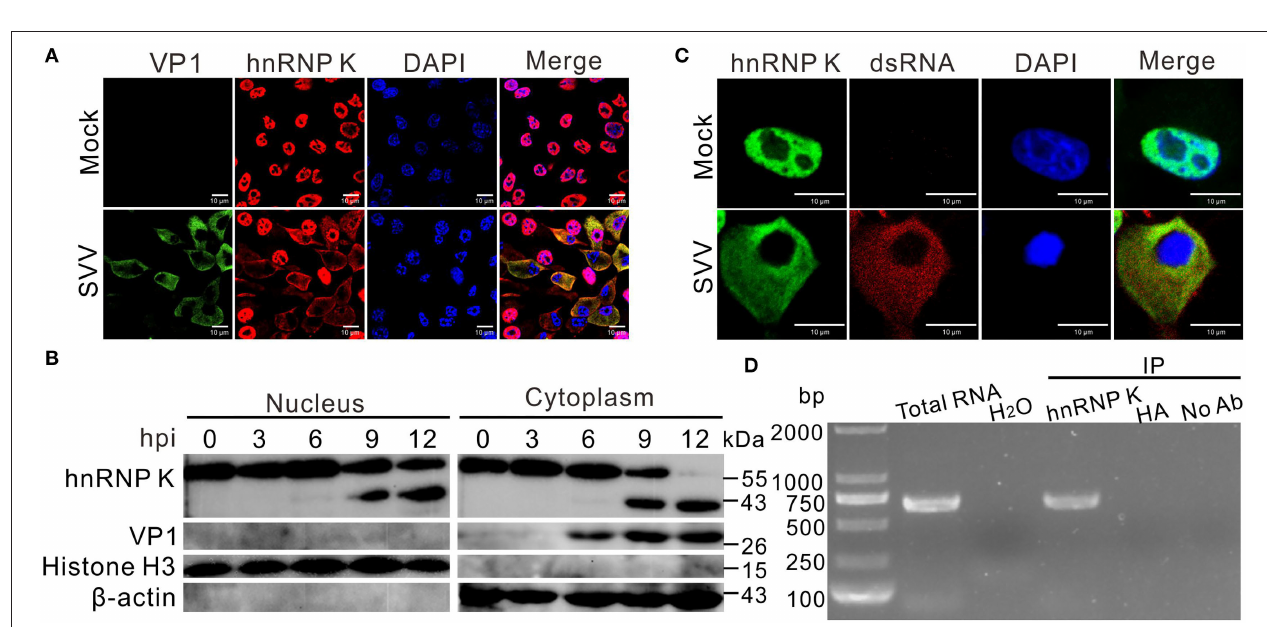
FIGURE 1 | SVV infection cleaves hnRNP K and induces hnRNP K degradation. (A,D) SVV-infected (MOI = 5) or mock-infected BHK-21 or PK-15 cells were extracted at 0, 3, 6, 9, 12, and 24 hpi, and protein samples were subjected to Western blotting with antibodies against hnRNP K, VP1, and β -actin. (B,E) Graphs of quantification analyzed with Image J, the level of hnRNP K band ratios normalized to β -actin. Statistical analysis using GraphPad Prism. Results are displayed as the mean ± standard deviation (SD) of three independent tests (*** P < 0.001; NS, not significant). (C,F) SVV-infected (MOI = 5) or mock-infected BHK-21 cells were harvested at 0, 6, and 12 hpi and the mRNA levels of hnRNP K were quantified by qRT-PCR. Statistical analysis using GraphPad Prism. Results are displayed as the mean ± SD of three independent experiments (** P < 0.01; NS, not significant).